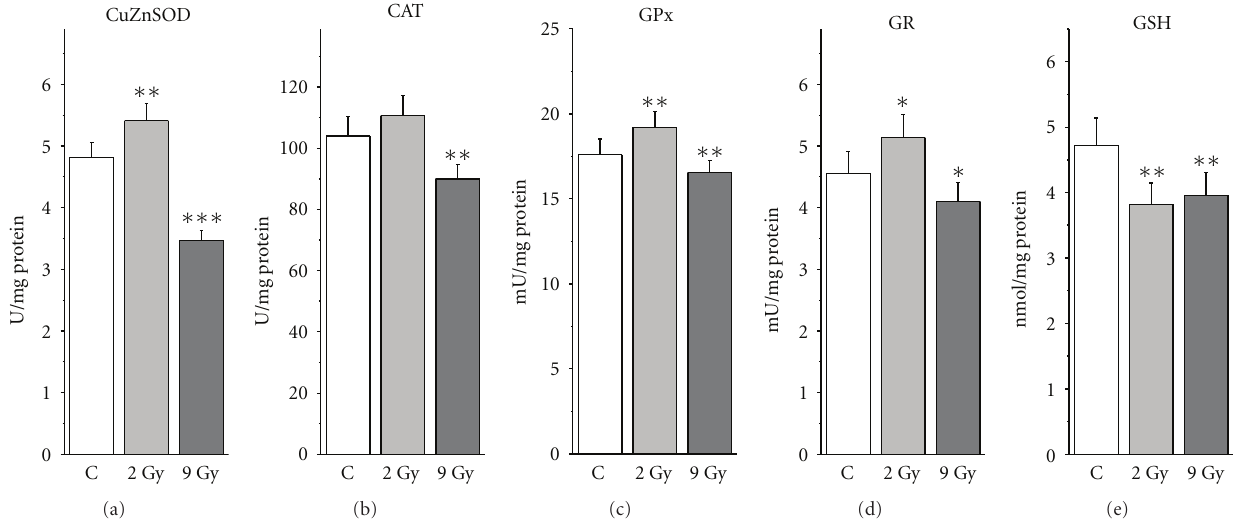
Figure 2: AO enzyme activities and concentration of GSH in blood cells nonirradiated (C) and irradiated with 2Gy and 9 Gy of γ -radiation, in healthy women aged 45–58 years. The data are given in mean values ± SEM; ∗ P < 0 . 05, ∗∗ P < 0 . 01, ∗∗∗ P < 0 . 001 in comparison to C (student’s paired t